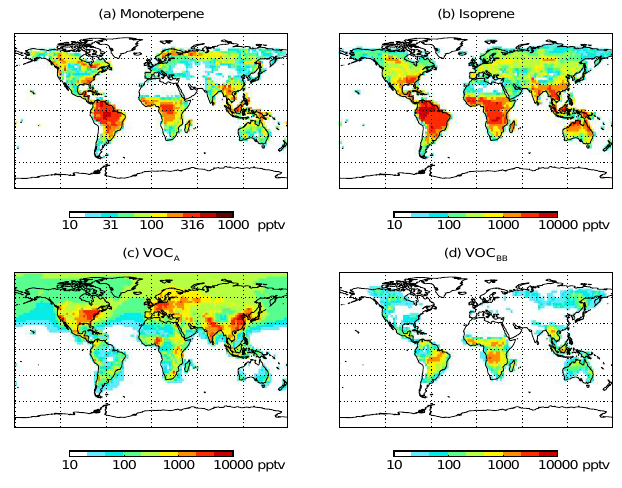
Fig. 1. Simulated annual mean surface concentrations of (a) monoterpene, (b) isoprene, (c) anthropogenic VOC (VOC A ) , (d) biomass burning VOC (VOC BB ) .